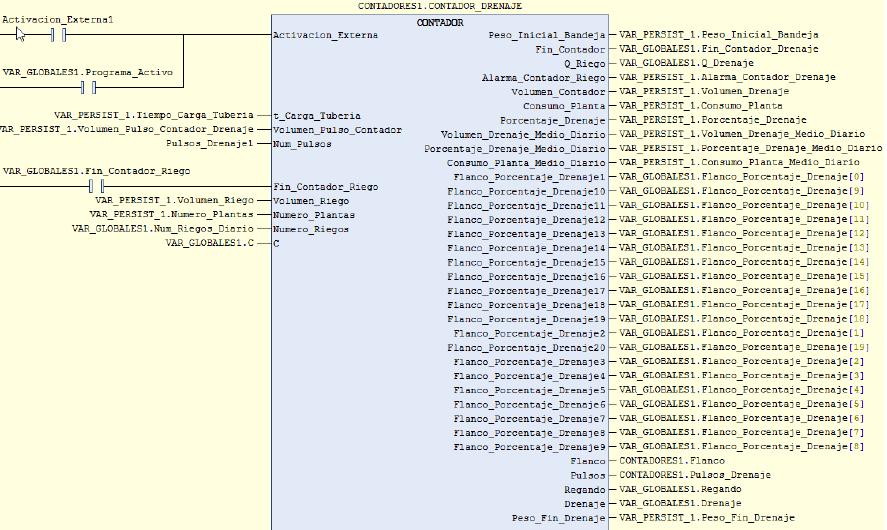
Figure A3. Example of Function block in Codesys software using variable structure.